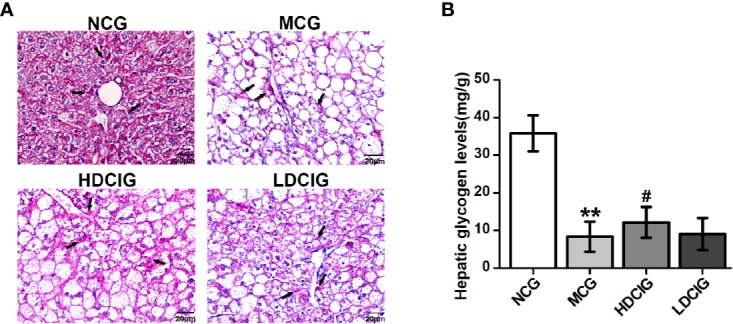
Results of PAS staining of liver tissues obtained from each group of mice. (A) Representative images of liver tissue stained with PAS (200×) are listed. Arrows indicate hepatic glycogen. (B) The hepatic glycogen levels of db/db mice are measured. All values are expressed as means ± SD, n=10. **P < 0.01 vs. (NCG) mice; #P < 0.05 vs. model control group (MCG) mice.